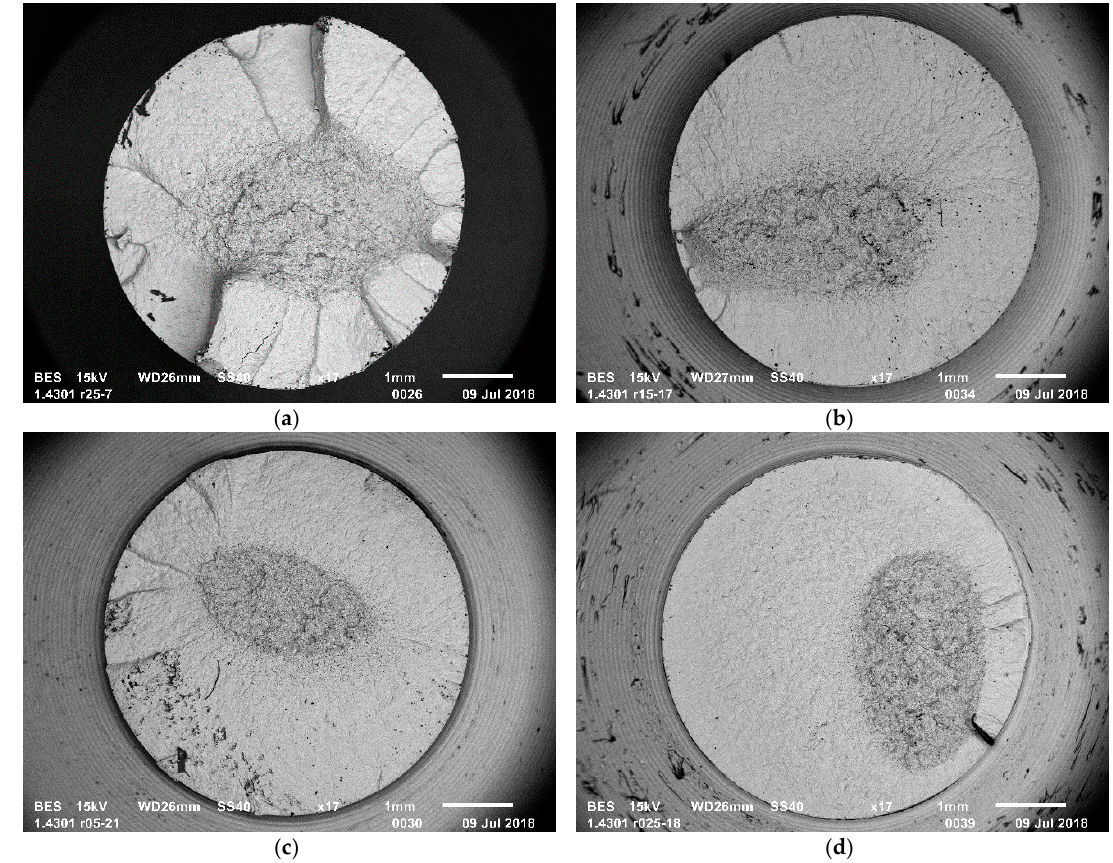
Figure 5. Fatigue fracture of specimen ( a ) smooth; ( b ) notched r = 1.5; ( c ) notched r = 0.5; ( d ) notched r = 0.25. Table 3. Mechanical properties for the 1.4301 steel.